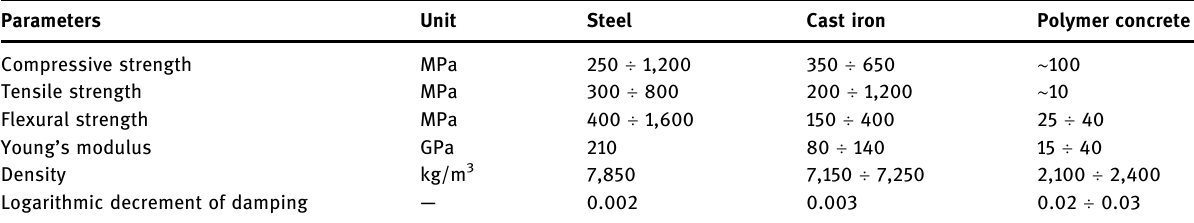
Logarithmic decrement of